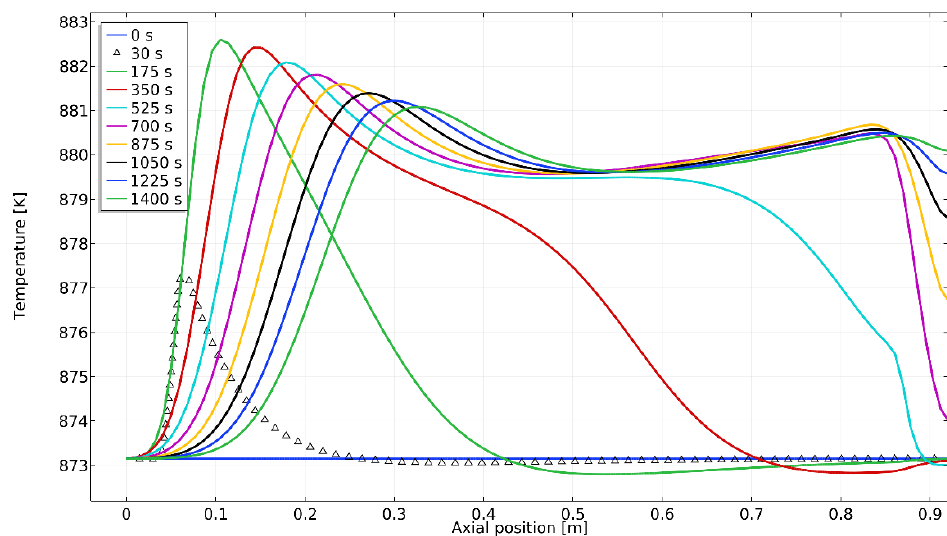
Figure 15. Model predicted axial temperature profiles during reduction with syngas.